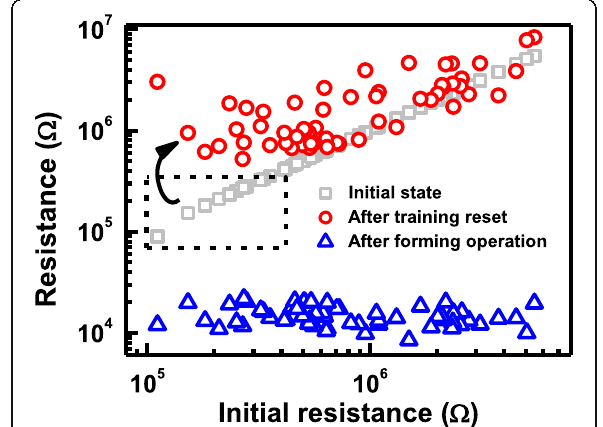
Fig. 14 A blanket reset training operation is proposed to be applied on the CRRAM array. Resistance in cells with low R ini is increased by annihilating intrinsic defects, but cells with high R ini is not